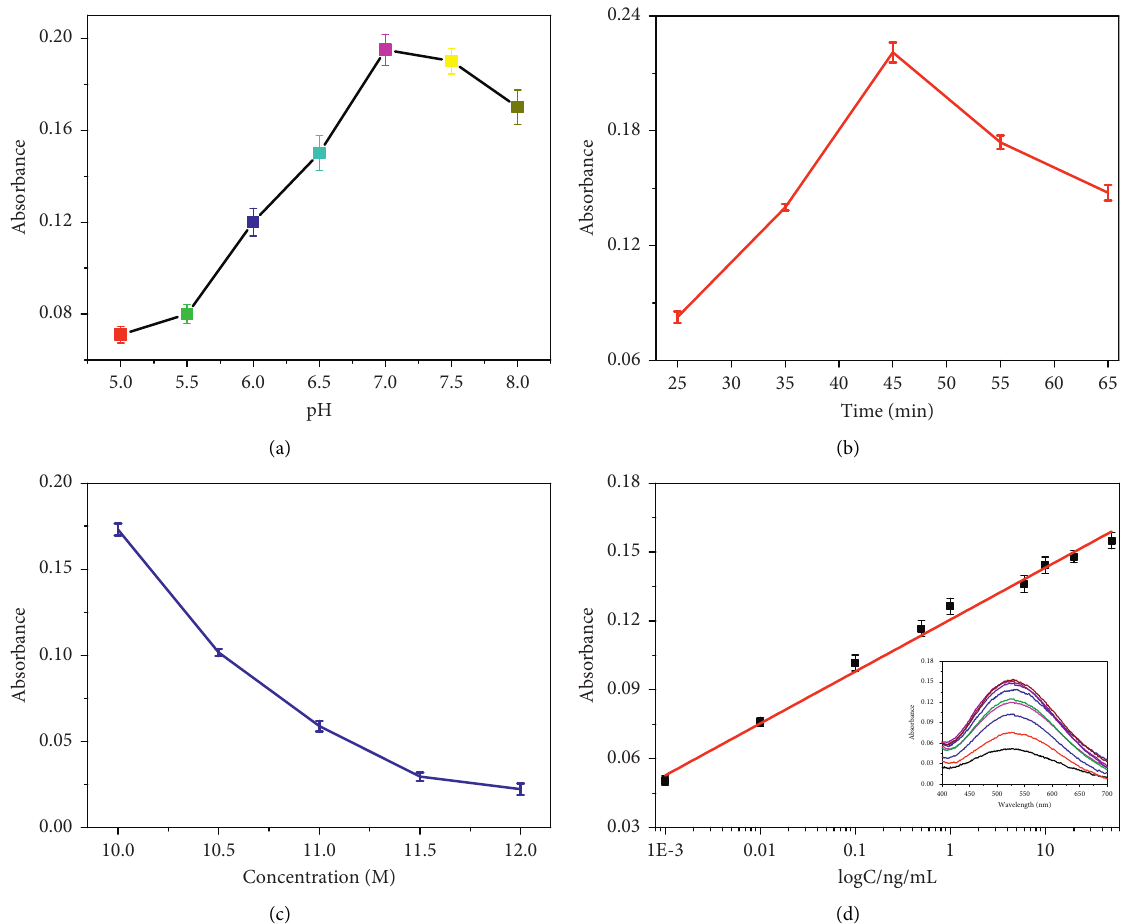
Figure 3: The effect of (a) pH of phosphate buffer solution, (b) incubation time of antibody and antigen, and (c) HCl concentration. (d) Calibration plot of CEA levels (the inset: UV-vis absorption spectrums in 400 nm–700 nm of colorimetric immunoassay toward different CEA